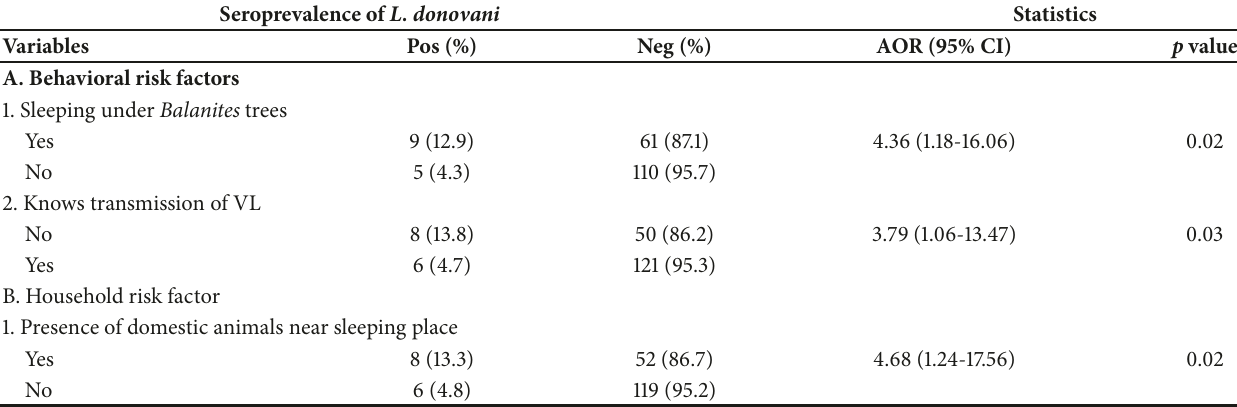
Table 4: Multivariable logistic regression of associated risk factors for the seroprevalence of asymptomatic Leishmania donovani . Seroprevalence of L.